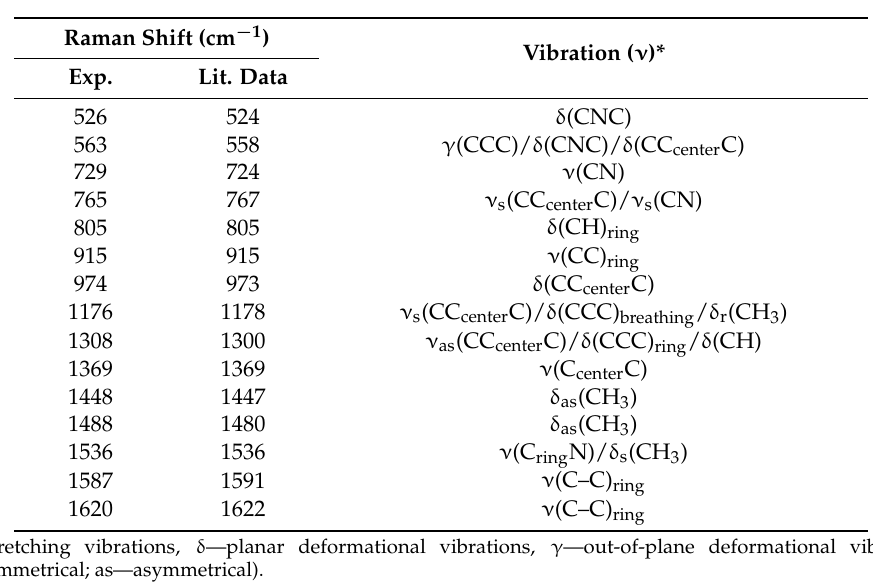
Table 4. The frequencies and shapes of vibrations in Raman spectra recorded for writing ink containing dyes from the triarylmethane group (B-type) and data from the literature corresponding to crystal violet dye.